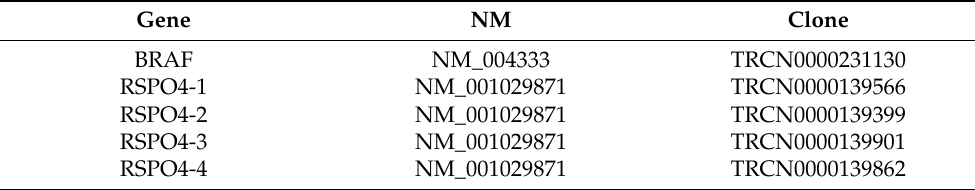
Table 2. Sequences used for RSPO4 and BRAF knockdown.